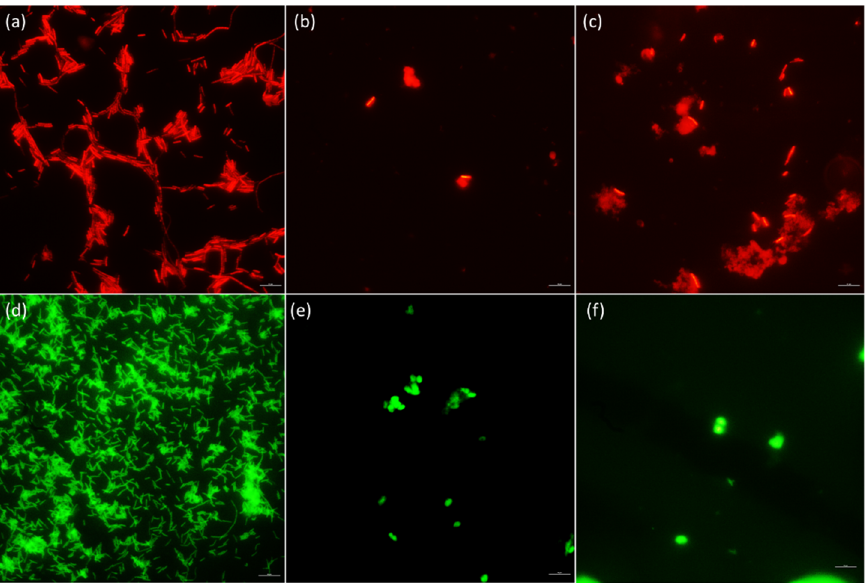
Figure 3. FISH of intestinal samples taken from totoaba fed with SPC30Pro diet at the beginning and end of the trial; ( a ) low G + C Gram-positive control strain ( Bacillus subtilis 9b); ( b ) Low G + C Gram-positive bacteria from intestine samples at the beginning of the study; ( c ) Low G + C Gram-positive bacteria from intestine samples at the end of the study; ( d ) γ -Proteobacteria control strain ( Vibrio harveyi ATCC14126); ( e ) γ -Proteobacteria from intestine samples at the beginning of the study; ( f ) γ -Proteobacteria from intestine samples at the end of the study.